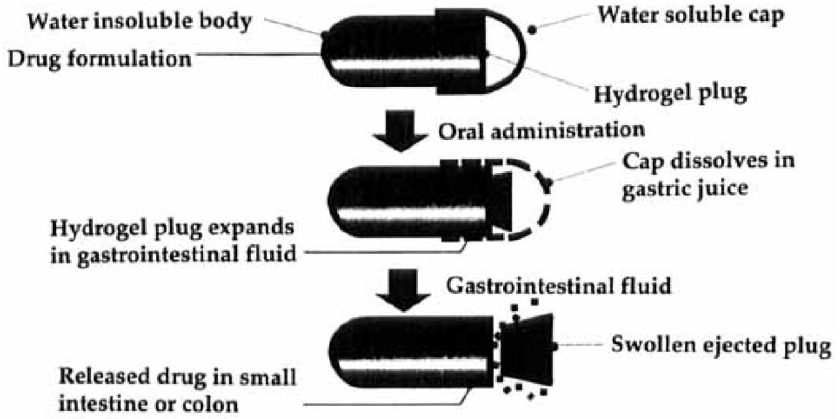
Figure 10. Schematic representation of the Pulsincap™ System. Reprinted with permission from Ref. [47]. 1997, Taylor & Francis. Table 2. Transit and plug separation times (h) of placebo units in six fasted volunteers. Adapted with permission from Ref. [47]. 1997, Taylor &